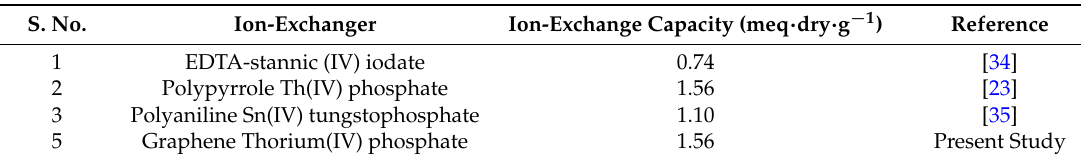
Table 2. A comparison of ion-exchange capacity of previously reported lead-selective composite materials with the present study.